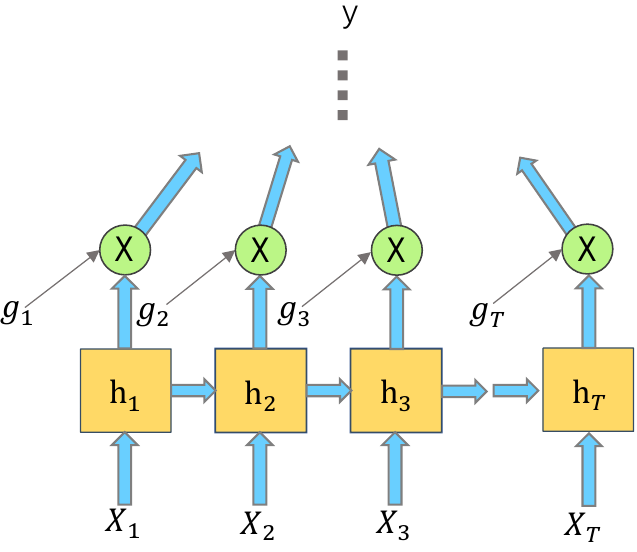
Figure 3. Backbone network.